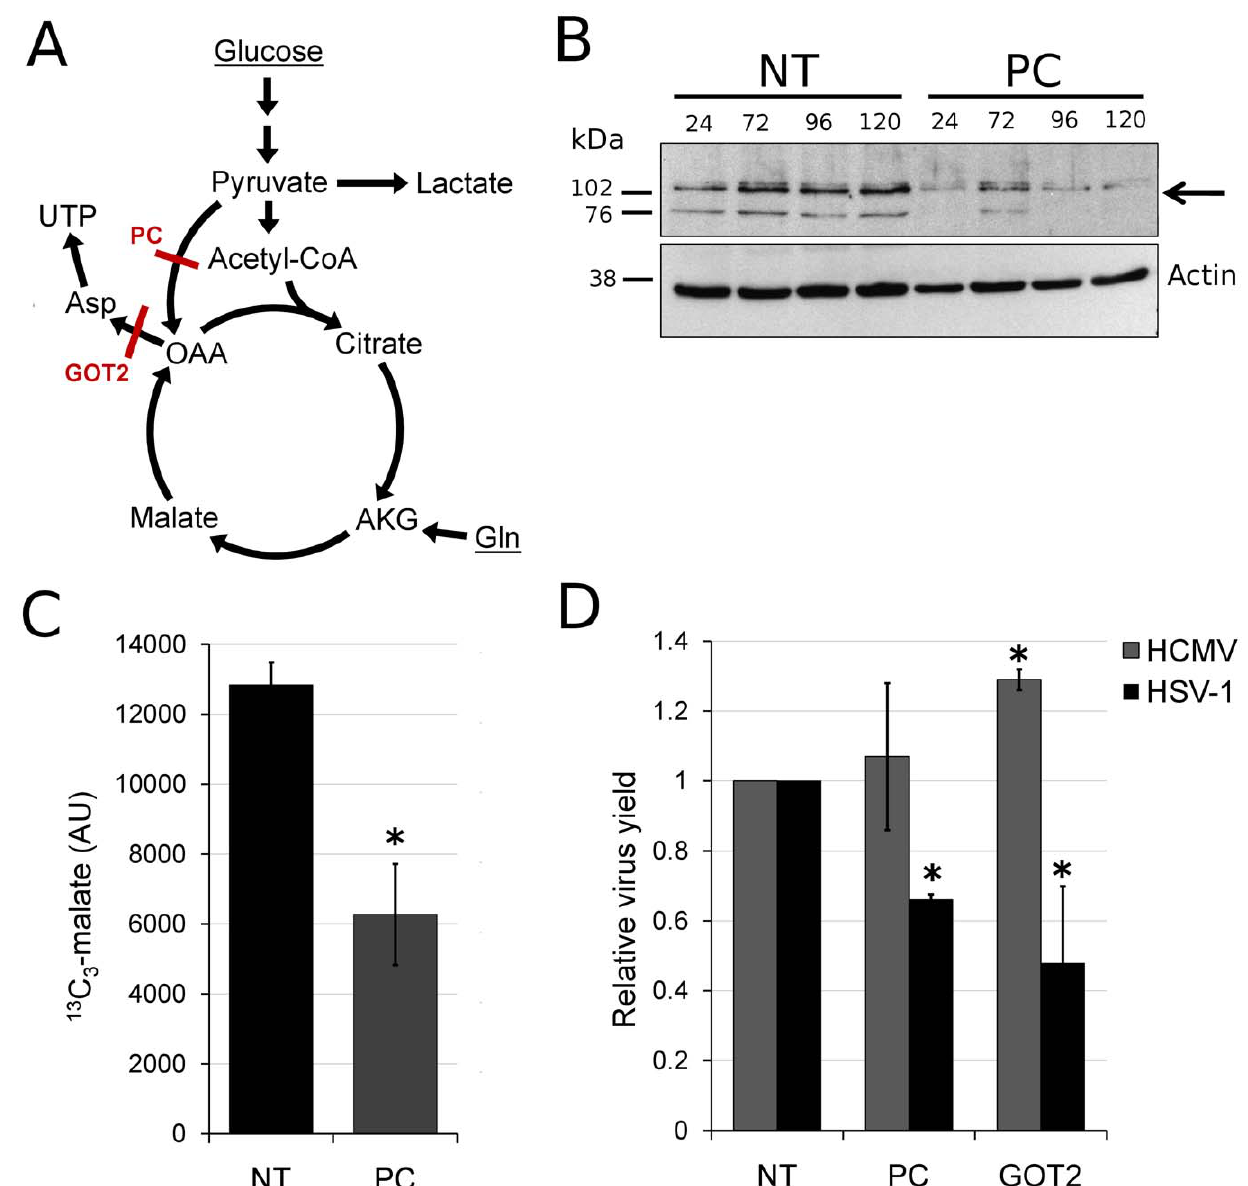
Figure 7. HSV-1 replication is inhibited by reducing flux from glucose toward pyrimidine nucleotide synthesis. ( A ) Schematic diagram of glucose flux to pyrimidine nucleotide biosynthesis. Red lines mark siRNA-targeted reactions catalyzed by pyruvate carboxylase (PC) and aspartate transaminase 2 (GOT2). (OAA: oxaloacetate, AKG: oxoglutarate, Gln: glutamine). ( B ) RNA interference knockdown of pyruvate carboxylase (marked by arrow) in MRC5 cells. Cells were transfected with non-targeting siRNAs (NT) or siRNAs targeting pyruvate carboxylase (PC) and harvested at indicated time points after transfection. Pyruvate carboxylase levels in the cells were detected by western blot using specific antibodies. Beta-actin was employed as a loading control. ( C ) Buildup of 13 C 3 -labeled malate after switching MRC5 cells to uniformly 13 C-labeled glucose medium for 2 hours at 10 hpi of HSV-1 (F) infection. The cells have been transfected with a universal non-targeting siRNA (NT) or an siRNA targeting pyruvate carboxylase (PC) 120 h prior to infection (significance: p=0.007). Symbols indicate experimental data points 6 1 s.d.; n=3; values are given in arbitrary units. ( D ) Production of infectious HSV-1 (F) and HCMV (AD169) virions in cells transfected with siRNAs against pyruvate carboxylase (PC), aspartate transaminase 2 (GOT2), or a universal negative control (NT). The transfection and infection of MRC5 cells were performed as described in Materials and Methods. Values are expressed relative to non-targeting control ( 6 1 s.d.; n=3). Conditions resulting in significantly altered virus production (p # 0.05) compared to treatment with the universal negative control are marked with a